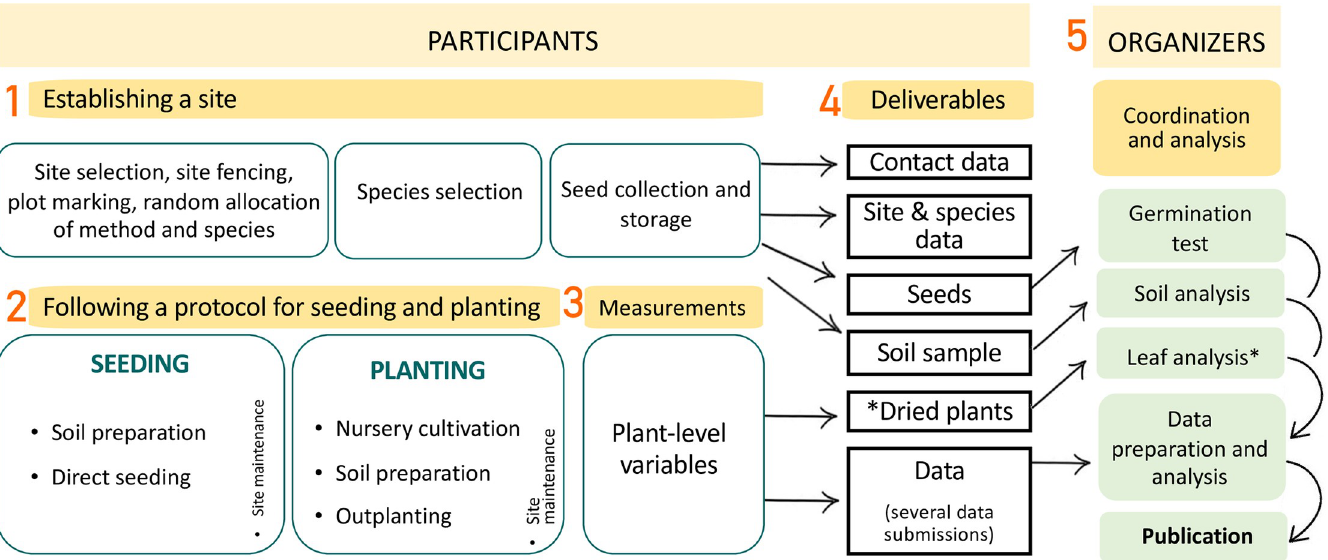
Fig 2. Schematic representation of the experiment. The activities are grouped by those to be conducted by each participant and those for the organizers. The deliverables in the rectangular boxes will be sent to, and processed by, the organizing team at the University of Granada. � Dried plants may be posted at the end of the experiment for chemical analysis in case of availability of additional funding.